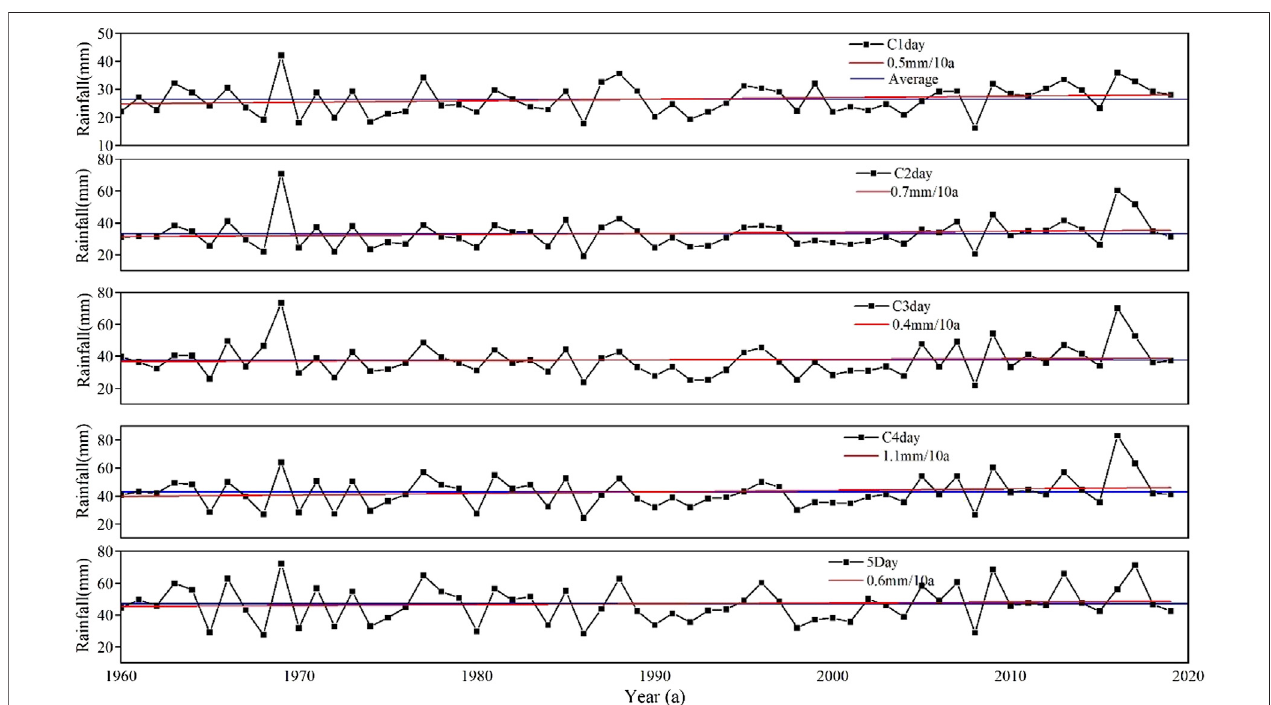
FIGURE 4 | Results of simple linear regression analysis.